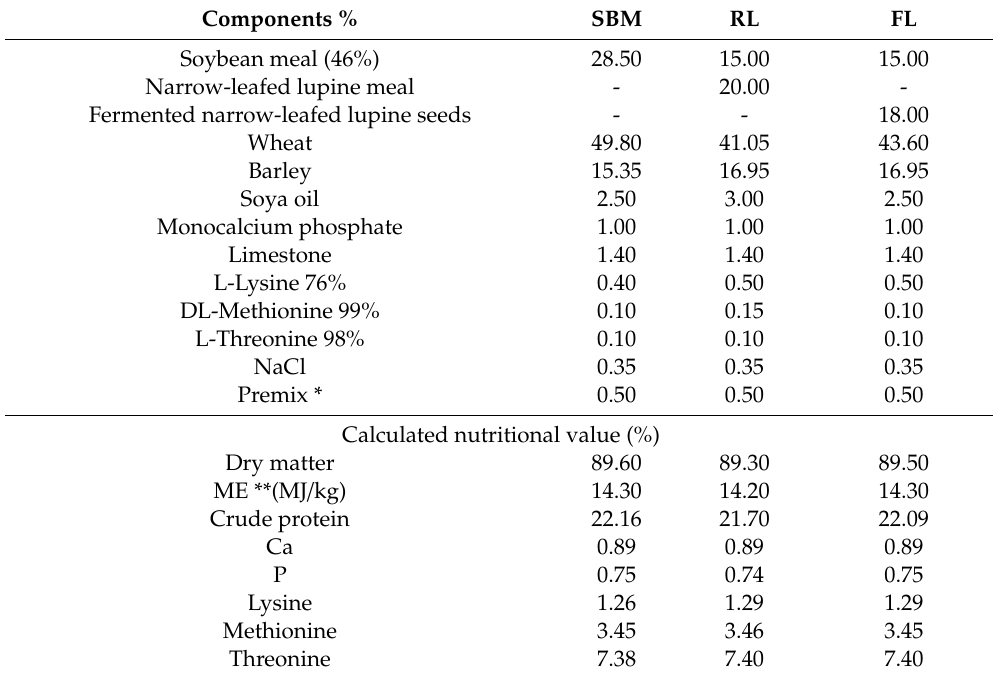
Table 1. The composition and nutritional value of